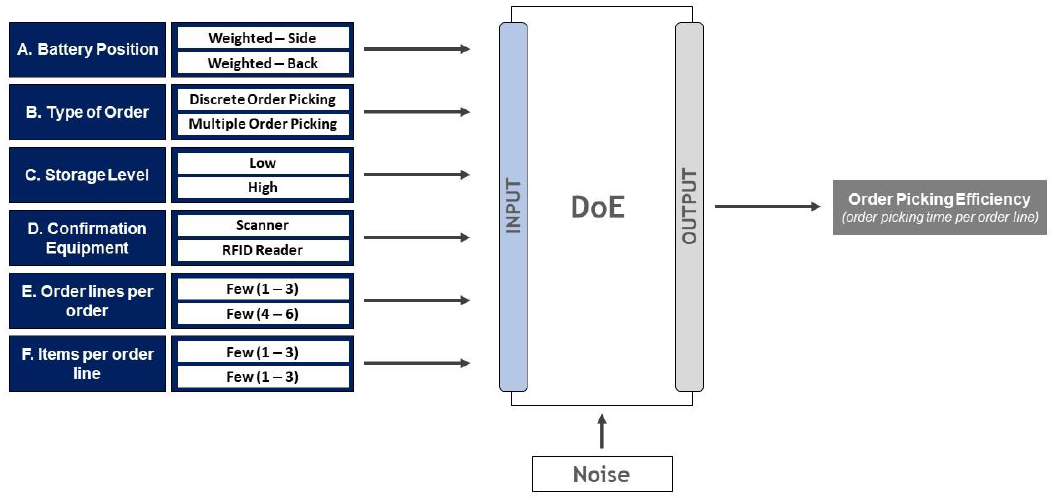
Figure 3. Model for predicting order-picking efficiency.